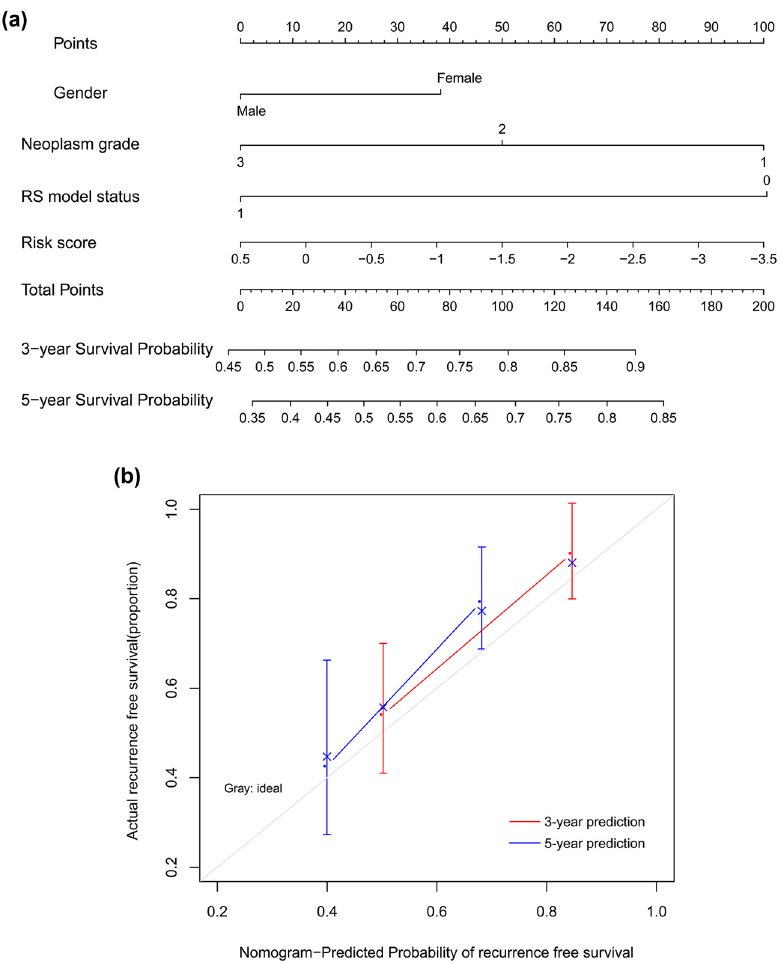
Figure 5: Nomogram to predict 3 - year and 5 - year probability of recurrence - free survival using TCGA set. ( a ) nomogram based on gender, neoplasm grade, and risk score model status. RS model status = four - lncRNA risk score model status. ( b ) calibration curves of actual and predicted